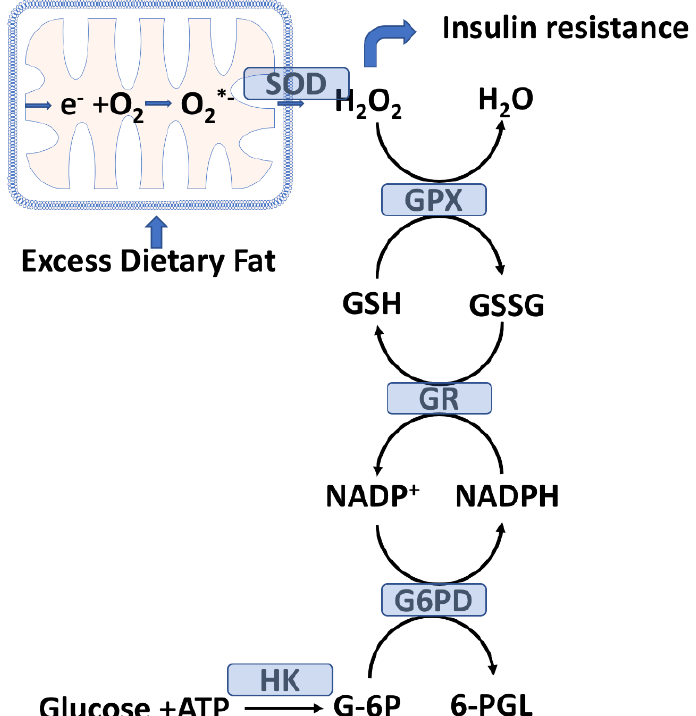
Figure 2. A model linking excess dietary fat to skeletal muscle mitochondrial emission of H 2 O 2 , insulin resistance, and the glutathione peroxides system. Excess dietary fat promotes electron leakage and the production of superoxide (O 2 •− ) anion radicals. Superoxide dismutase (SOD) converts O 2 •− to H 2 O 2 , which is reduced by glutathione peroxidase (GPX) with the consumption of reduced glutathione (GSH) and the formation of oxidized glutathione (GSSG). GSSG is recycled back to GSH by glutathione reductase (GR) with the consumption of NADPH and the formation of NADP + . Glucose-6-phosphate dehydrogenase (G6PD), in turn, catalyzes the reduction of NADP + to NADPH utilizing glucose-6-phosphate (G-6P) provided by the action of hexokinase (HK) on glucose. Excess H 2 O 2 emission into the skeletal muscle cytoplasm has been linked to insulin resistance (see text) and a shift to reduced levels of GSH and increased levels of GSSG.